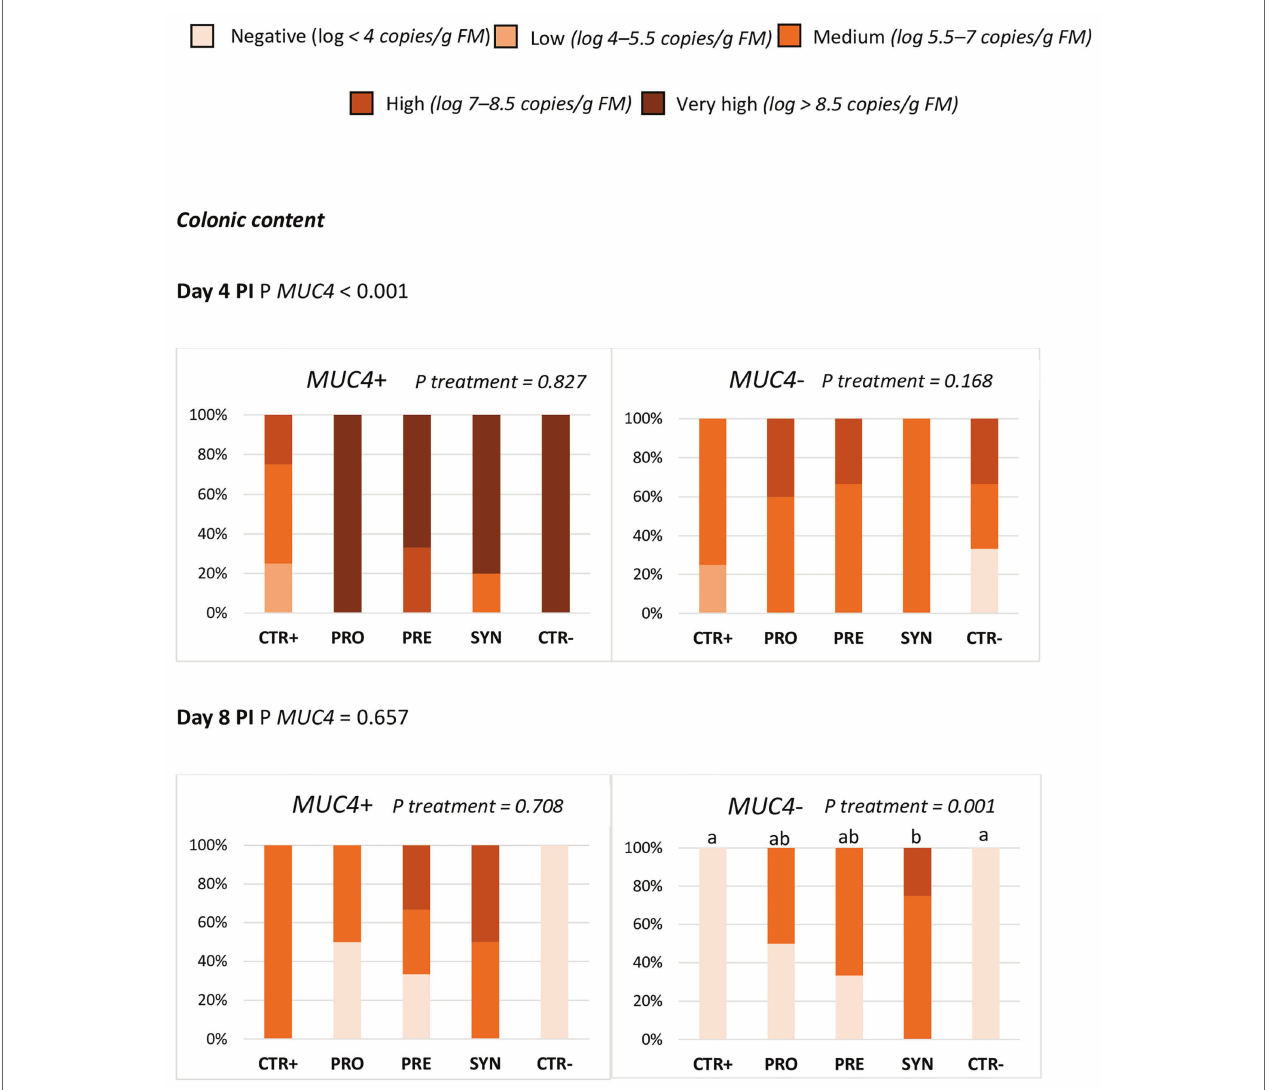
FIGURE 3 | Effect of MUC4 polymorphism on the percentage of animals with different levels of ETEC F4 counts in colon content on days 4 and 8 post- inoculation (PI). Different animals were sampled on days 4 and 8 post-inoculation (PI). CTR+: non-inoculated animals receiving placebo; PRO − : inoculated animals receiving the probiotics; PRE: inoculated animals receiving the prebiotic; SYN: inoculated animals receiving the synbiotic; CTR − : inoculated animals receiving placebo. N = 6 for all groups except for non-challenged animals ( N = 8). Values of p were obtained using Fisher’s exact test in R software. a and b indicate statistically significant differences between groups. MUC4 +, Mucin 4 susceptible genotype; MUC4 − , Mucin 4 resistant genotype; PI, post-